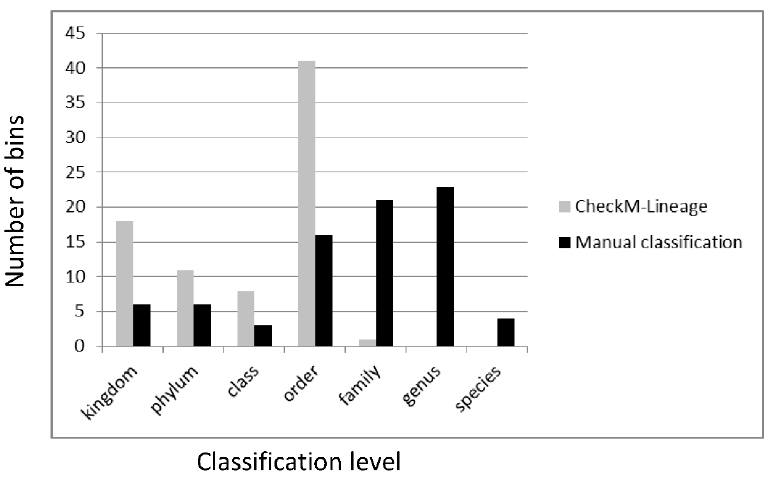
Figure 3. Taxonomic classification of 79 bins with a completeness of >80% obtained from three cyanobacterial metagenomes (Table S5). Gray columns show the automated classification by CheckM, black columns document the respective level after manual classification (RpoB, text mining).